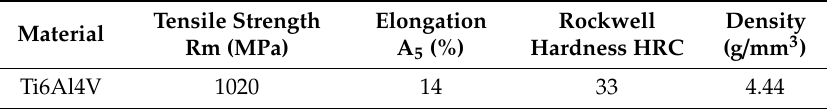
Table 1. Mechanical properties of the material Ti6Al4V.